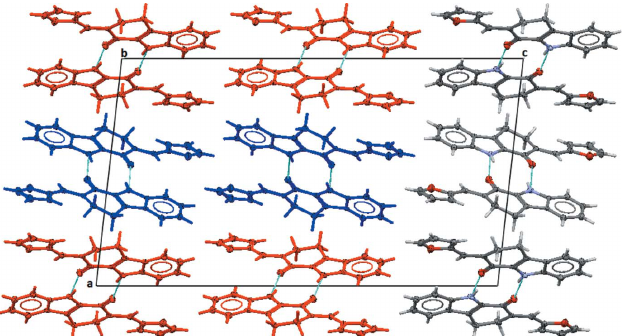
Figure 3 Crystal packing of the title compound, viewed along the b axis, showing the hydrogen bonded A – A and B – B inversion dimers, with R 2 motifs. The N—H (cid:2)(cid:2)(cid:2) O hydrogen bonds are shown as dashed lines (see Table 1; molecule A blue, molecule B red).